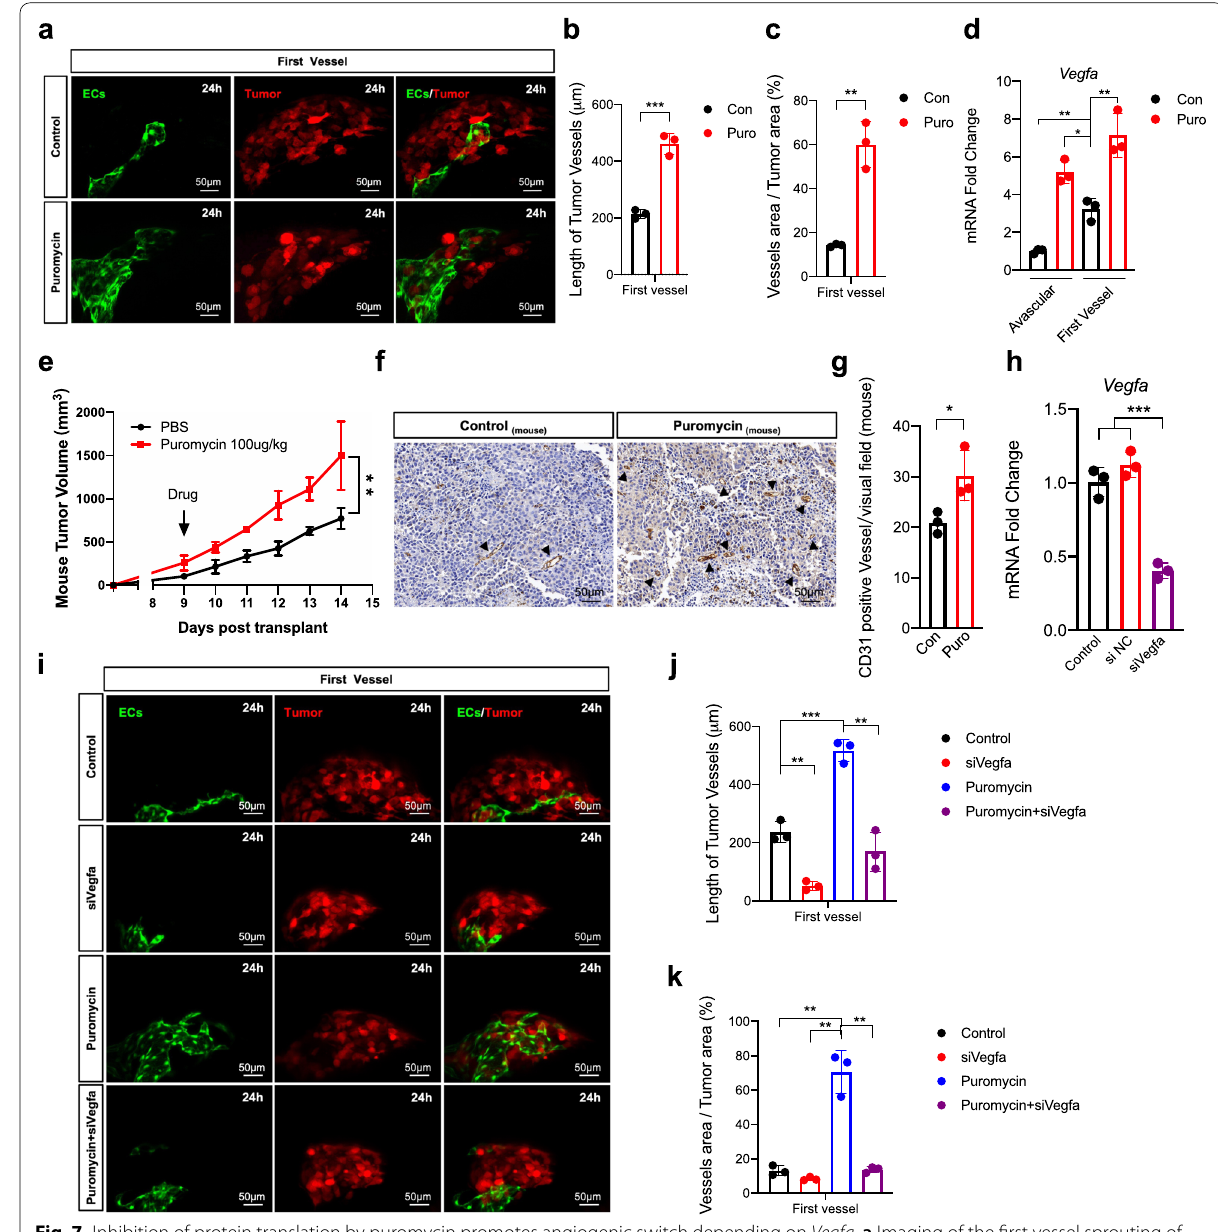
Fig. 7 Inhibition of protein translation by puromycin promotes angiogenic switch depending on Vegfa . a Imaging of the first vessel sprouting of B16-Red transplant microtumors treated with puromycin (2 μg/mL) for 24 h before transplant. Scale bar, 50 μm. b and c The length of vessels and the ratio of vessels area versus tumor area of the first vessel. d RT-qPCR quantification of the Vegfa expression in the puromycin treated microtumors during the angiogenic switch(about 12 h and 24 h). e The mouse tumor volume of puromycin (100ug/Kg, intratumor) treated tumors. f CD31 staining of mouse tumors on day 14. Black arrow, CD31 positive tumor vessels. Scale bar: 50 μm. g The density of CD31 positive mouse tumor vessels per visual field. h RT-qPCR quantification of the Vegfa expression in B16-Red cells transfected with Vegfa siRNA (100 μM) for 48 h ( n negative control. i Imaging of the first vessel sprouting of B16-Red transplant microtumors treated with puromycin (2 μg/mL) for 24 h, transfected with Vegfa siRNA (100 μM) for 48 h, and treated with puromycin (2 μg/mL) for 24 h and transfected with Vegfa siRNA (100 μM) for 48 h before transplant. Scale bar, 50 μm. j and k The length of vessels and the ratio of vessels area versus tumor area of B16-Red transplant microtumor of the first vessel. ECs are green. Tumor is red. Control, Con. Puromycin, Puro. Unpaired t-test, * P < 0.05, ** P < 0.01, *** P < 0.001 ( n